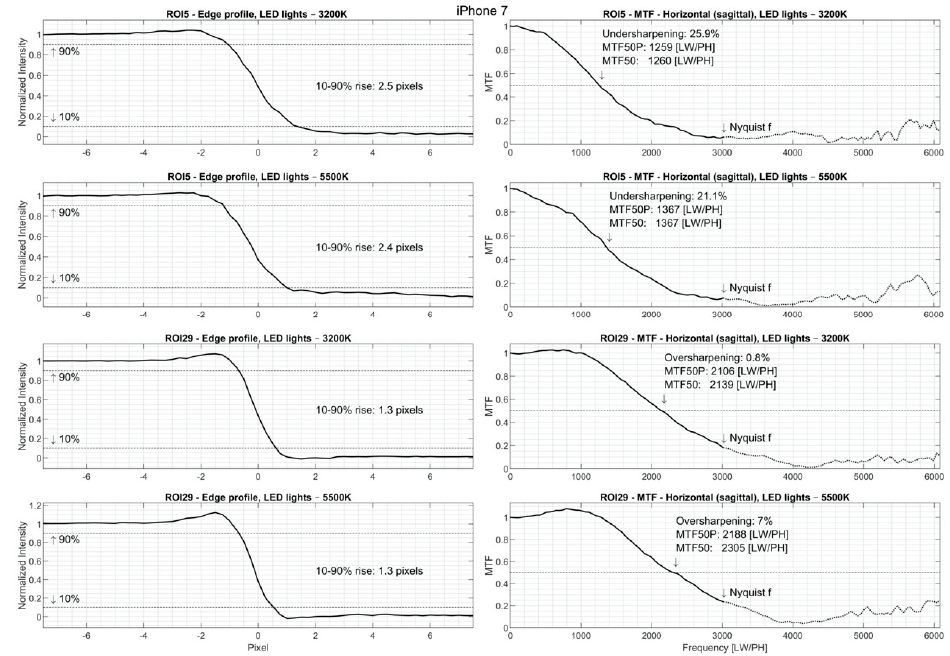
Figure 5. Edge profile curves and plots with the corresponding MTF for the higher left corner of the image (ROI5) and for the centre of the image (ROI29). Images were captured with the iPhone7 camera under different illuminations with calibrated LED lights (3200 K and 5500 K).